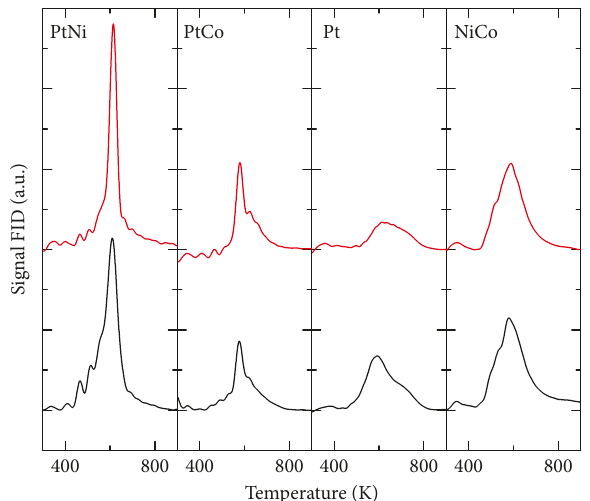
Figure 4: Temperature-programmed oxidation traces of dif- ferent catalysts. Catalyst coked during a test of 10 h (APR of aqueous ethylene glycol, 10%). UMC;